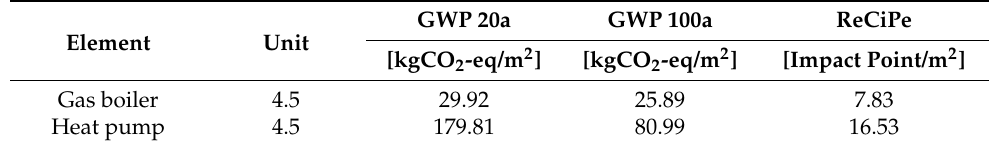
Table 9. Impact assessment during the manufacturing and disposal stage.